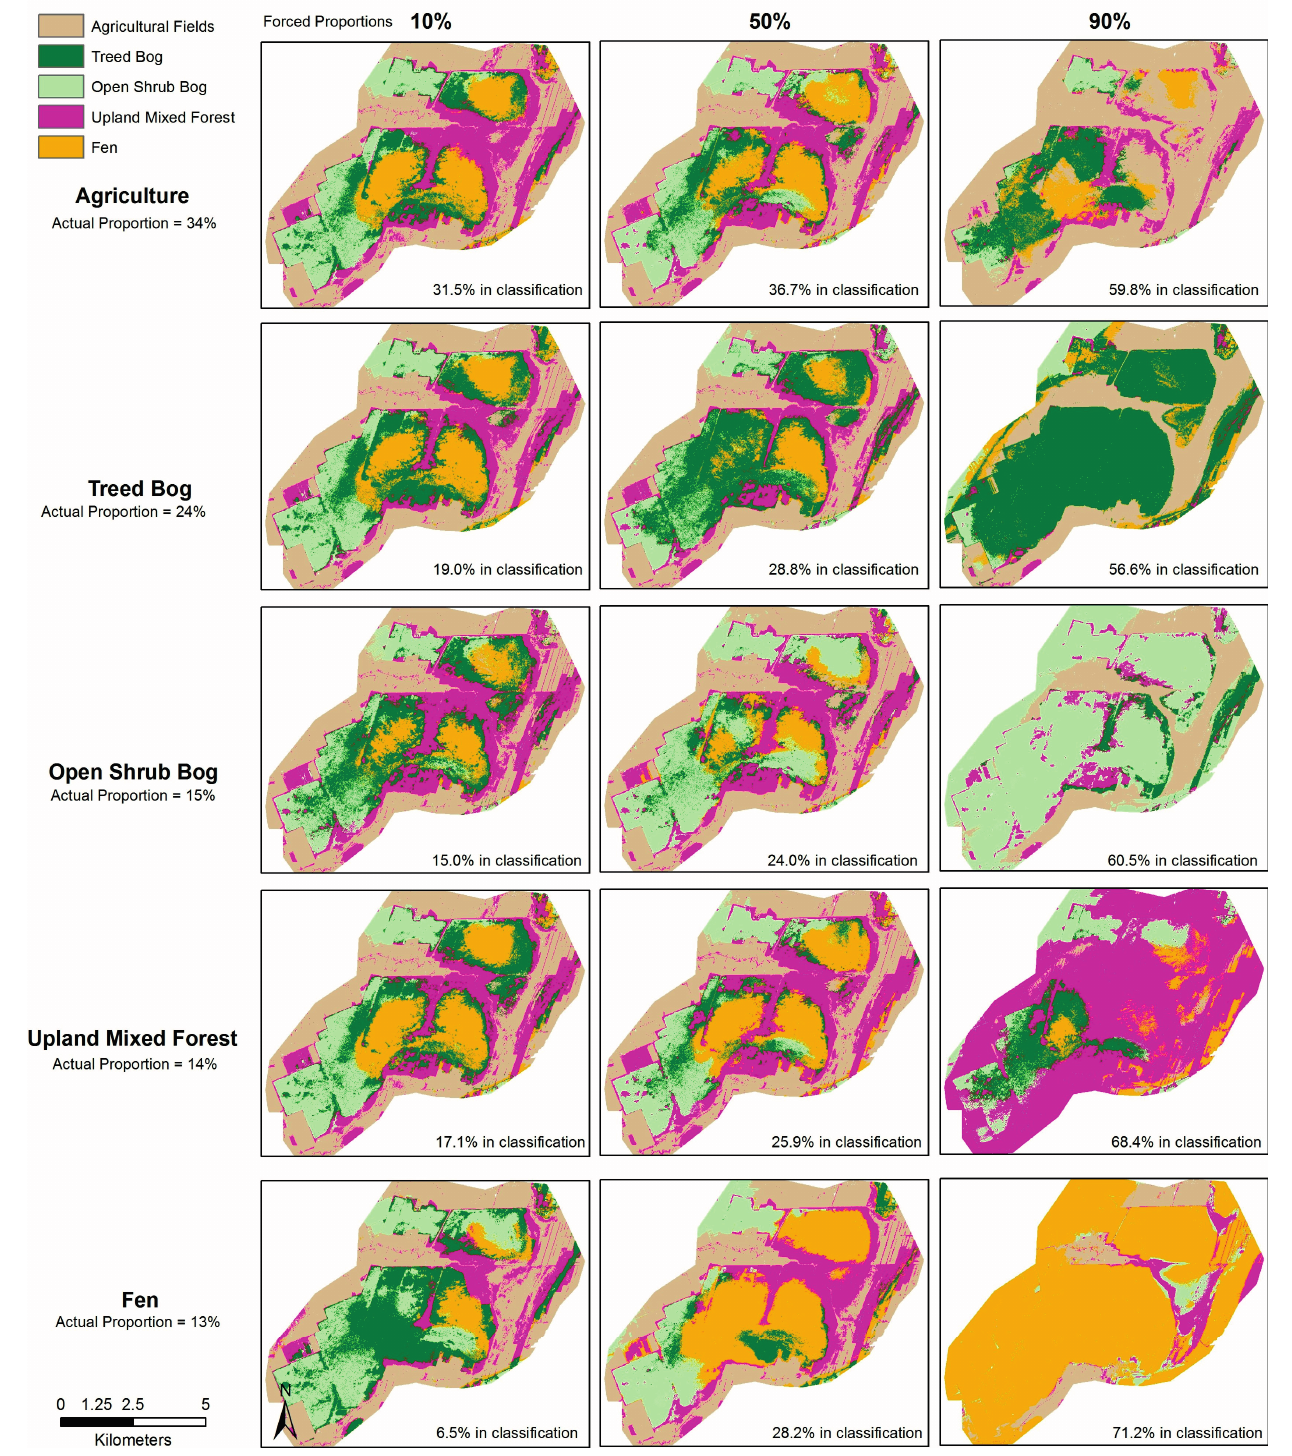
Figure 9. Classifications where training data were proportionally increased for a given class. In all cases, as the proportion of training data for the class increased, the difference between the actual and predicted proportions